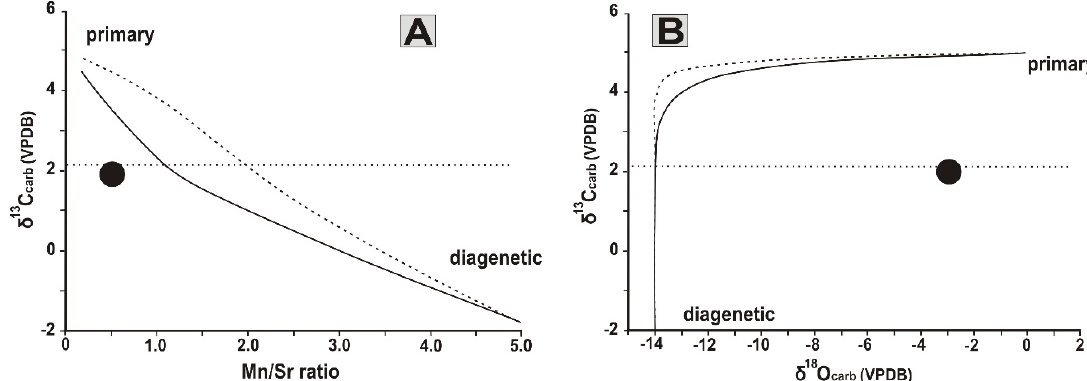
Figure 6. Modeled values to indicate the degree of post-sedimentary diagenetic alteration for the studied samples. ( A ) Mn / Sr ratio versus δ 13 C carb composition. ( B ) δ 13 C carb versus δ 18 O carb composition. The lines in A and B at ca. 2.2‰ represent the modern ocean surface water compared to 2‰ of Cretaceous Ocean average δ 13 C values. The black circle represents the Abu Roash A Member, whereby all samples plot slightly below and very close to the average δ 13 C values of modern ocean surface water and Cretaceous ocean water, respectively [38].